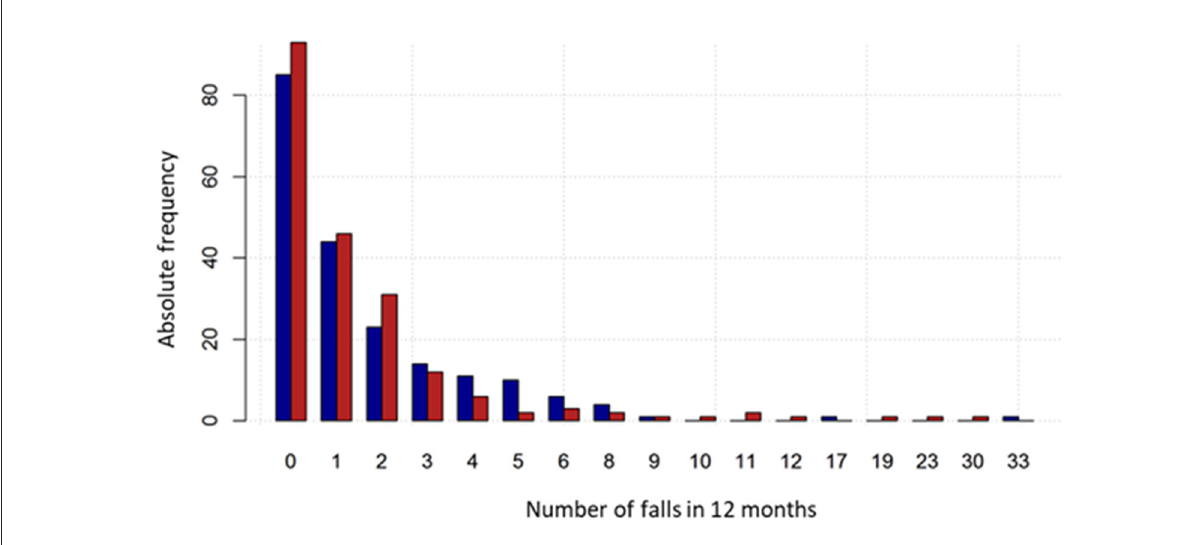
FIGURE3 Fall number distribution by group. The intervention group is represented by the red bars and the control group by the blue bars.